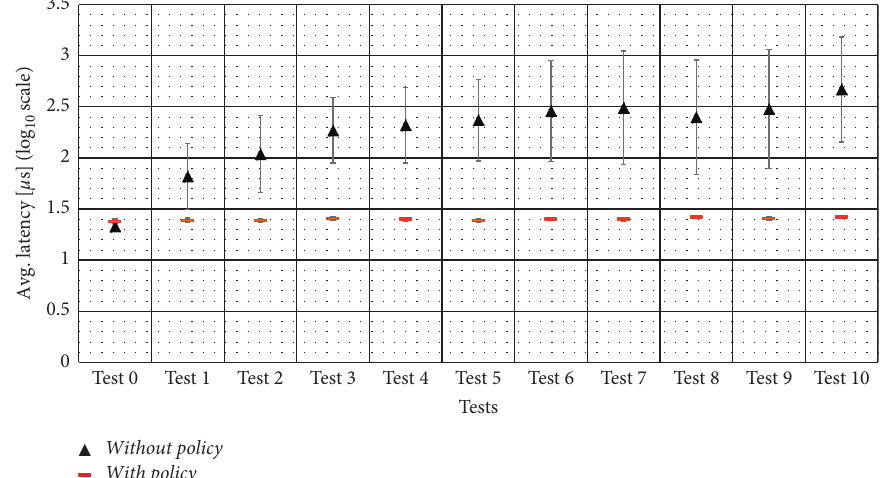
Figure 6: Average of transport layer latency.